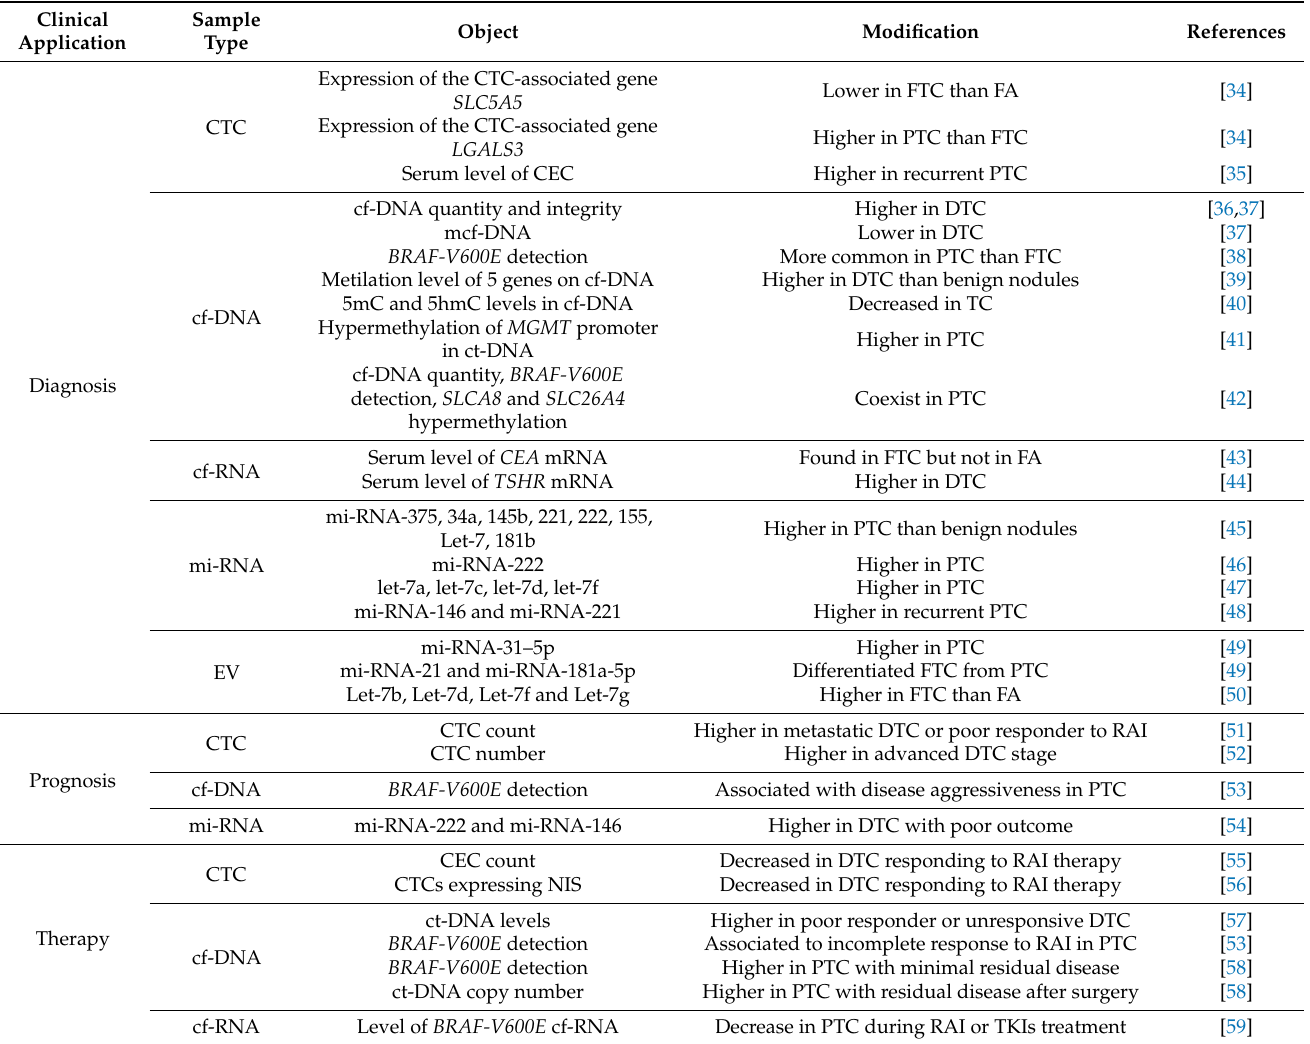
Table 1. Potential implications of liquid biopsy for the diagnosis, prognostic definition, and therapy of differentiated thyroid